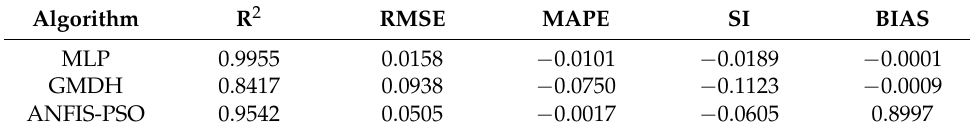
Table 5. Performance of the ML algorithms, in term of the adopted statistical indices.